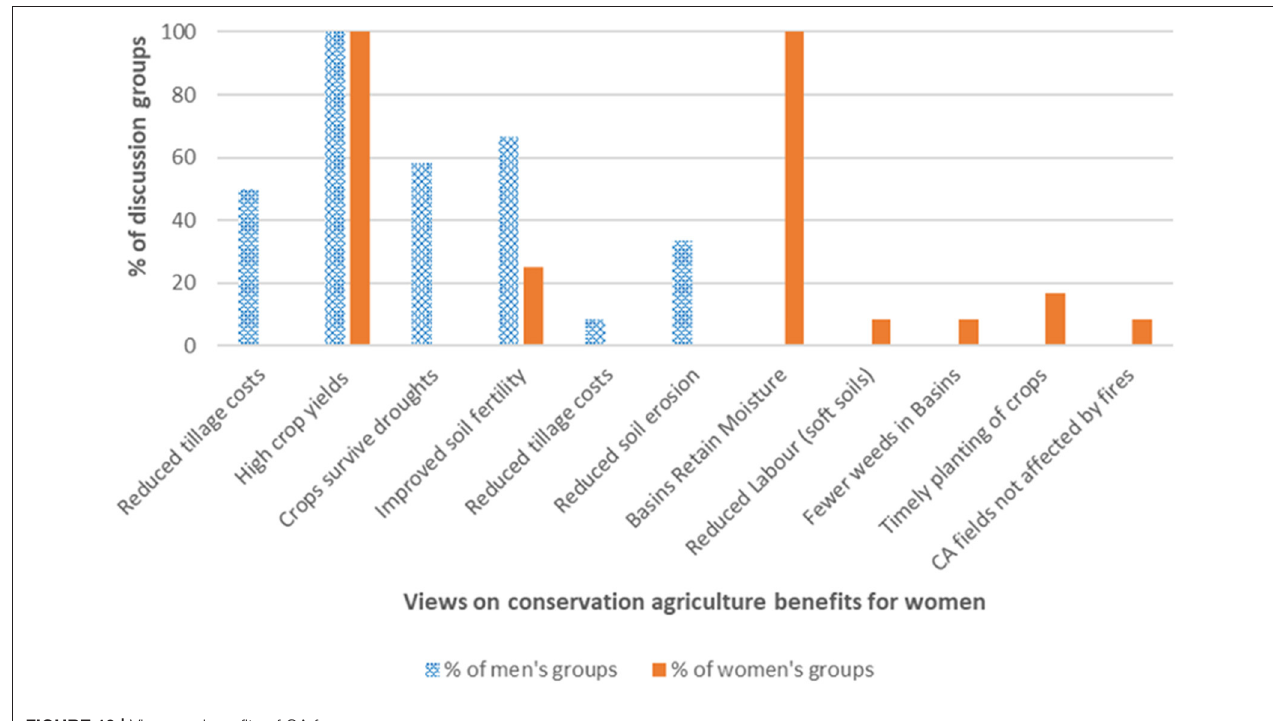
FIGURE 10 | Views on benefits of CA for women.